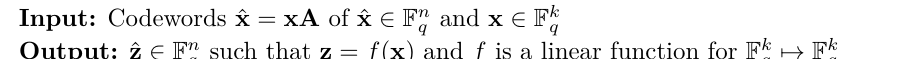
Algorithm 2: Improved L